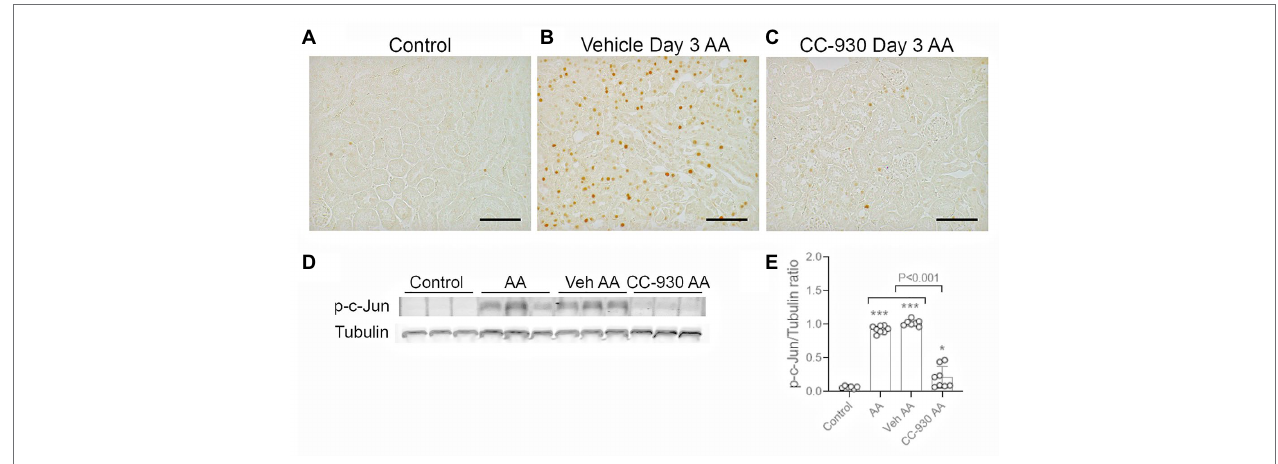
FIGURE 3 | c-Jun amino terminal kinase (JNK) signaling on day 3 of aristolochic acid (AA) induced acute kidney injury. AA injected mice were either untreated (AA), or treated with vehicle (Veh AA) or CC-930 (CC-930 AA) and compared to normal controls. (A-C) Immunohistochemistry staining for phospho-c-Jun Ser 63 . (A) Normal control kidney shows only very occasion p-c-Jun+ cells. (B) Vehicle treated AA shows large numbers of p-c-Jun+ nuclei, predominantly in tubular epithelial cells, including in damaged tubules. (C) CC-930 treated AA showing a dramatic reduction in p-c-Jun+ cells. Bars represent 100 μ m. (D) Western blot of kidney lysates for p-c-Jun and reprobed for α -tubulin. (E) Graph showing quantification of Western blots. One-way ANOVA with Tukey’s multiple comparison test. * p < 0.05 and *** p < 0.001 vs.